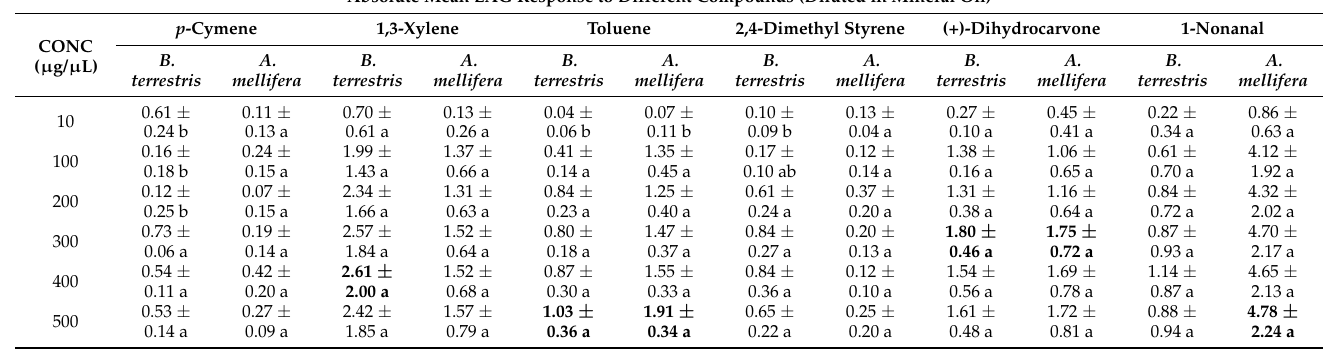
Table 3. Absolute mean EAG response with significant differences of A. mellifera and B. terrestris to different concentrations of the same